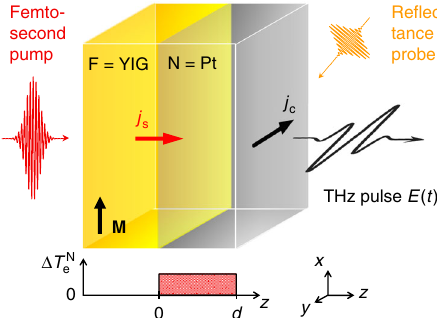
Fig. 1 Experiment schematic. To probe the ultimate speed of the spin Seebeck effect, a femtosecond laser pulse (duration 10 fs, center photon energy 1.6 eV) is incident on a F|N bilayer made of N = Pt (thickness of d = 5 nm) on top of F = YIG (thickness 5 µ m, in-plane magnetization M , electronic band gap of 2.6 eV). While the YIG fi lm is transparent to the pump pulse, the Pt fi lm is excited homogeneously, resulting in a transient increase Δ T N of its electronic temperature. Any ultrafast spin – current e density j s ( t ) arising in Pt is converted into a transverse charge – current density j c ( t ) by the inverse spin Hall effect, thereby acting as a source of a THz electromagnetic pulse whose transient electric fi eld E ( t ) is detected